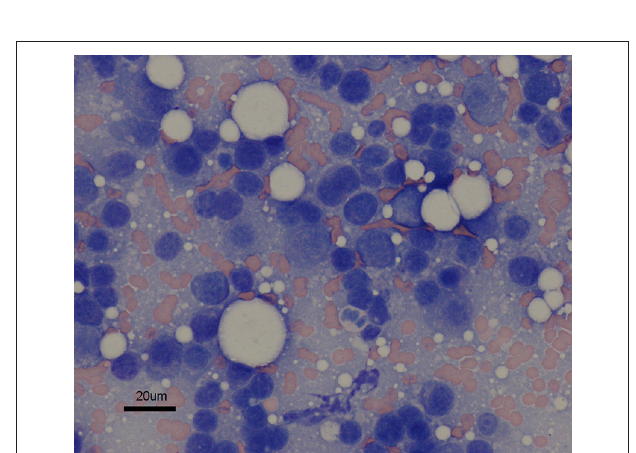
FIGURE 3 | Fine needle aspirate of cutaneous tail base mass. The discrete cells are small to medium in size and round to slightly ovoid in shape. They generally contain a single round nucleus eccentrically set in a small abundant amount of dark blue cytoplasm that occasionally contains a few pink granules. The nuclei exhibit a coarsely granular chromatin pattern. Moderate anisocytosis is noted. Hematoxylin and eosin; × 60 magnification; bar = 20 µ